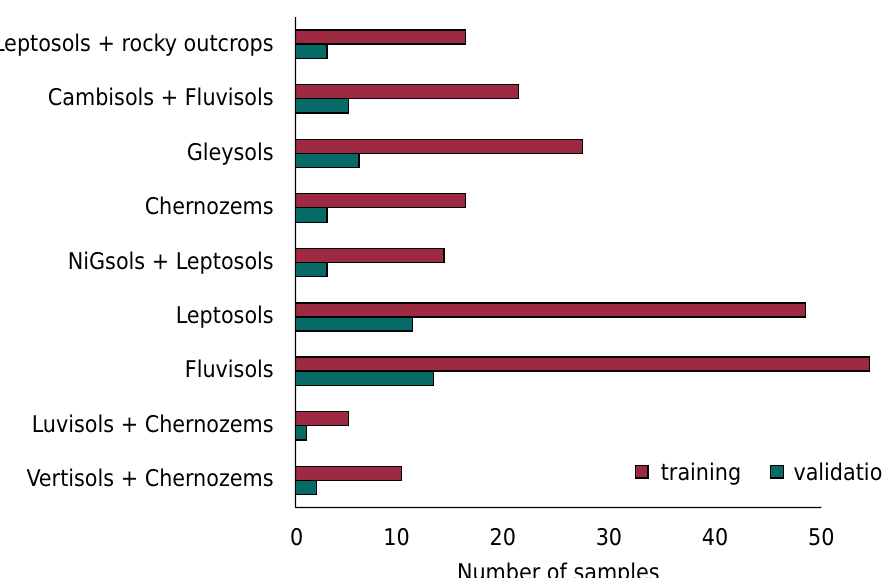
Figure 2. Distribution of soil classes in the training and validation dataset (n =